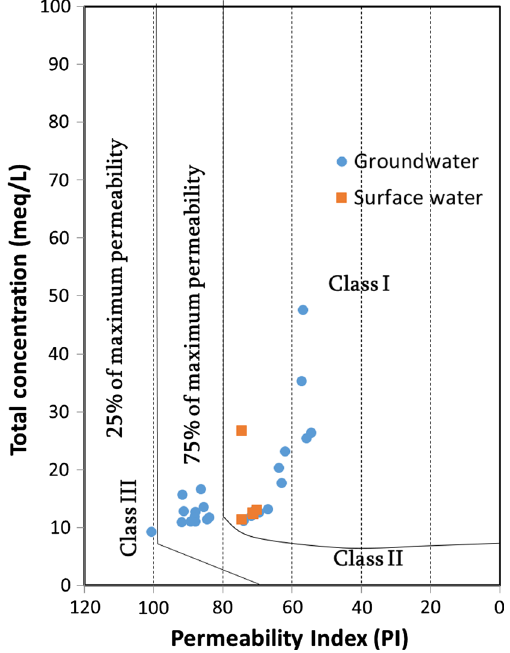
Fig. 19 Doneen (1964) classification of irrigation water quality based on the permeability